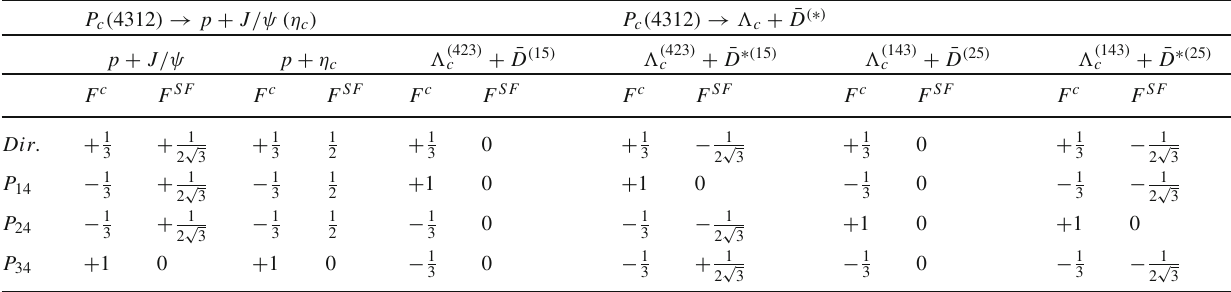
Table 2 Color coefficient F c and spin-flavor coefficient F SF for P c ( 4312 ) → p + J /ψ (η c ) and P c ( 4312 ) → (cid:3) c + ¯ D ( ∗ ) , where Dir . , ˆ P 41 , ˆ P 42 , and ˆ P 43 stand for the direct term, and permutations of (14), (24), and (34), respectively P c ( 4312 ) → p + J /ψ (η c )